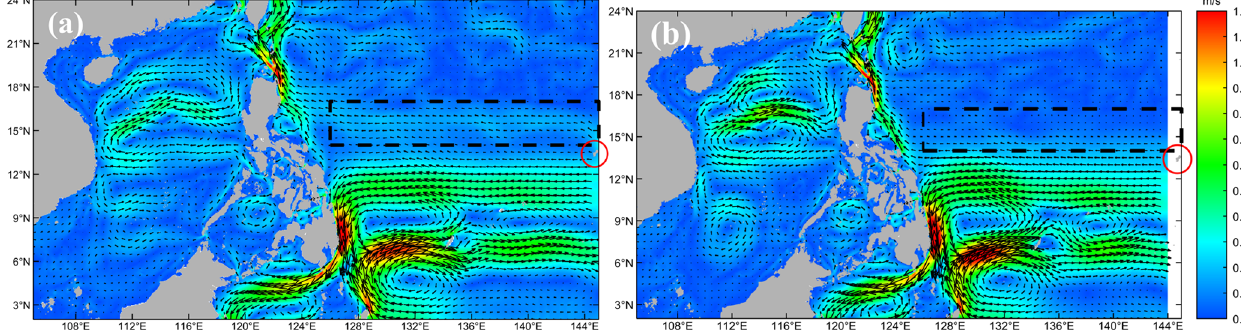
Figure 2. The multi-year monthly mean sea surface currents (the color shading indicates the current speed (ms − 1 ) , and the arrows denote the current direction) with vertical averages of > 100m in May. Panel (a) is from SCSOFSv1, with the model domain including Guam, and panel (b) is from SCSOFSv2, with the eastern lateral boundary moved 1 ◦ westward. Table 1. The main differences between SCSOFSv1 and